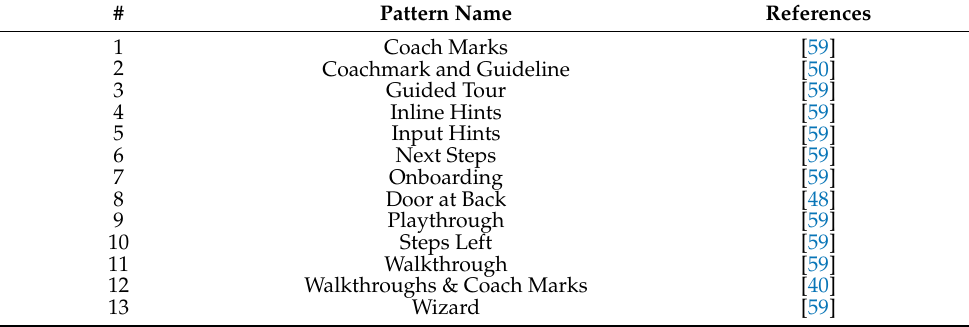
Table 16. Guidance MUIDPs.